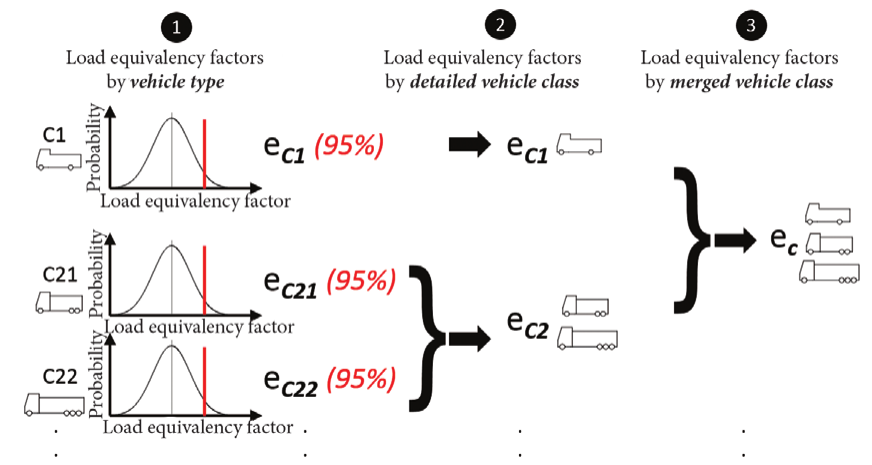
Fig. 5. Calculation of load equivalency factors for the detailed and merged vehicle classes Table 3. Current and calculated load equivalency factors for each vehicle type, the detailed and merged vehicle class Vehicle type Detailed vehicle class Merged vehicle